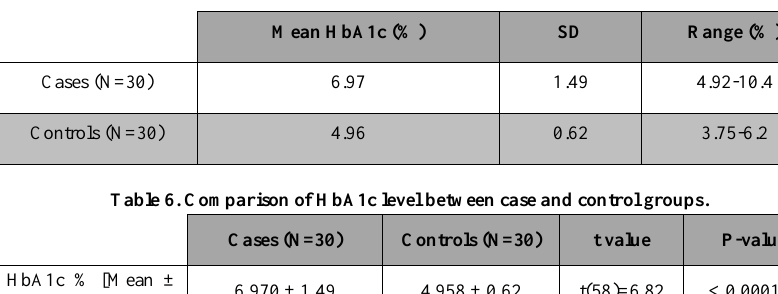
Table 5. Distribution of HbA1c level among case and control groups.